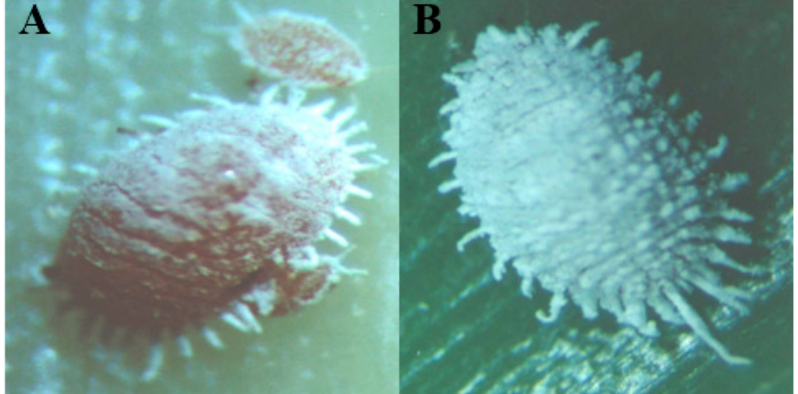
Figure 2. Pineapple mealybugs ( A ) Dysmicoccus brevipes ; ( B ) Dysmicoccus neobrevipes .